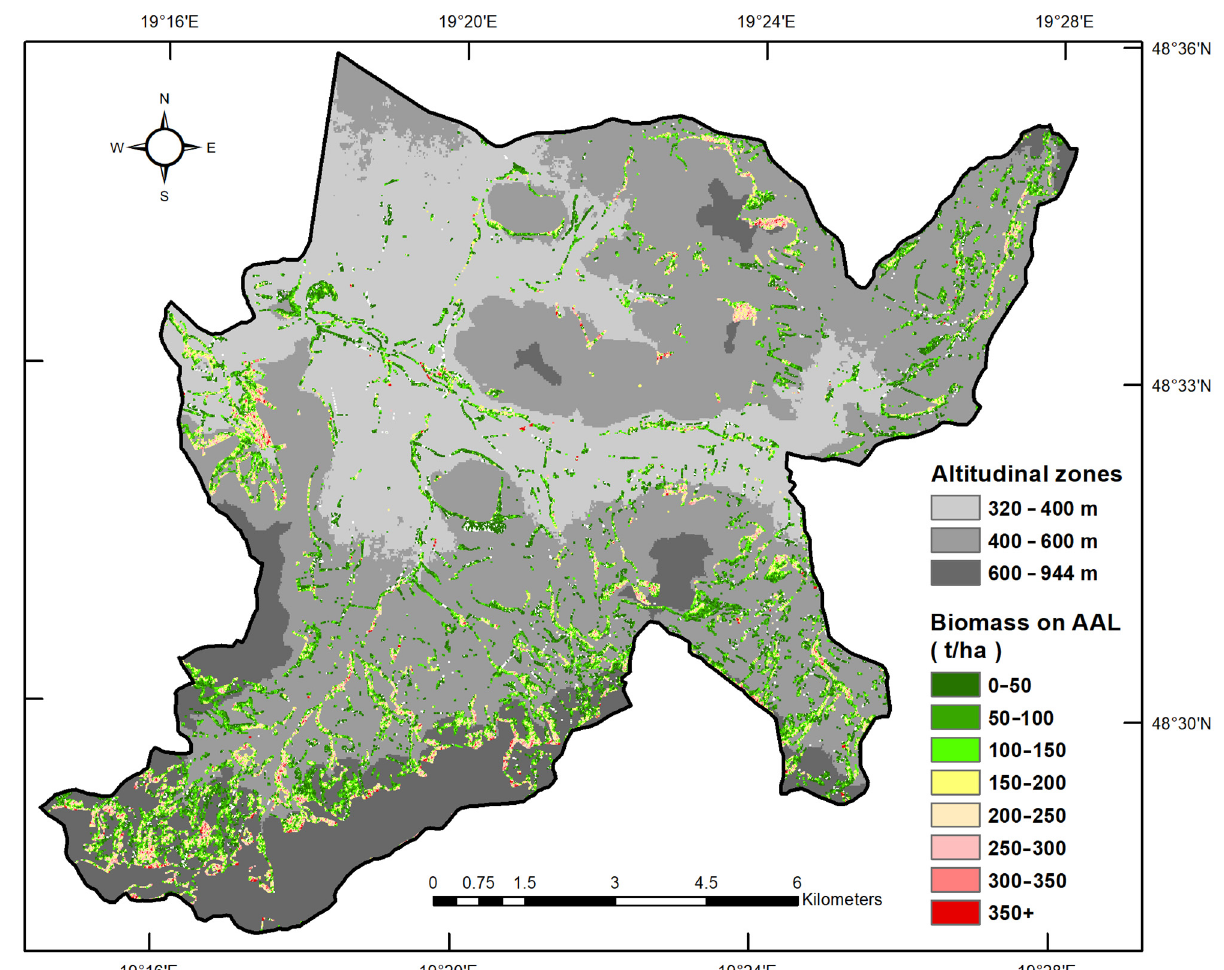
Figure 7. Distribution of predicted above-ground biomass on abandoned agricultural land in the study area of Viglas according to altitudinal zones (grey background colours). In order to enhance the visual perception, the number of pixels was magnified by a median filter with dimensions of 3 × 3 pixels.